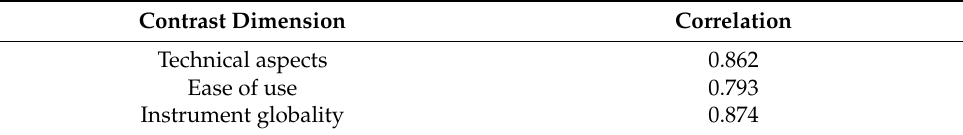
Table 9. Pearson’s correlation coefficient. Source: developed by the authors.